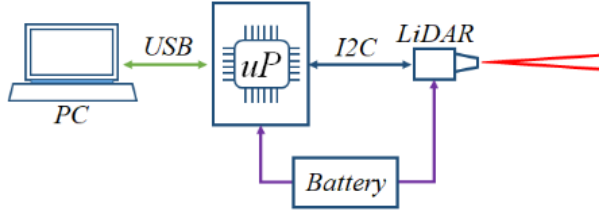
Figure 2. Experimental model basic diagram.